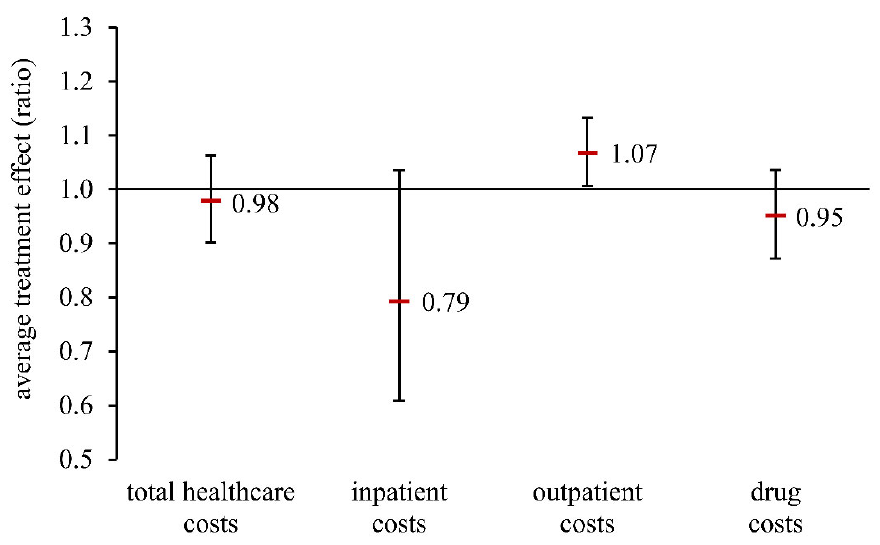
Figure 2. Average treatment effect (ratio of geometric means) in a population of patients newly diagnosed with CHD (doubly robust model). Total healthcare costs: sum of inpatient costs, outpatient costs, and drug costs.